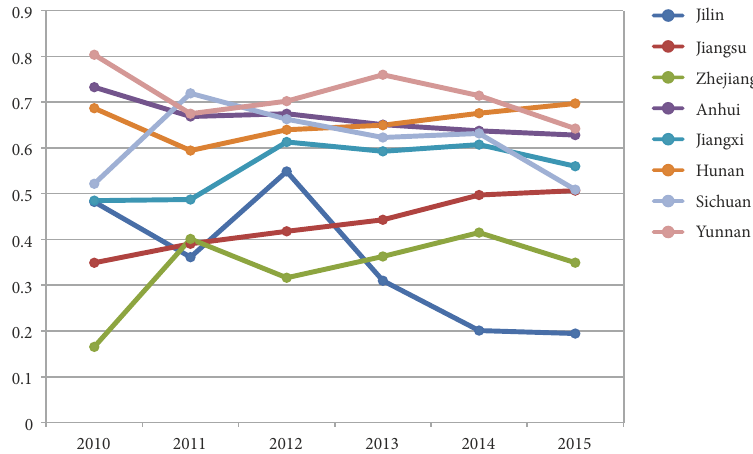
Figure 8. Disposal return rates of industrial waste